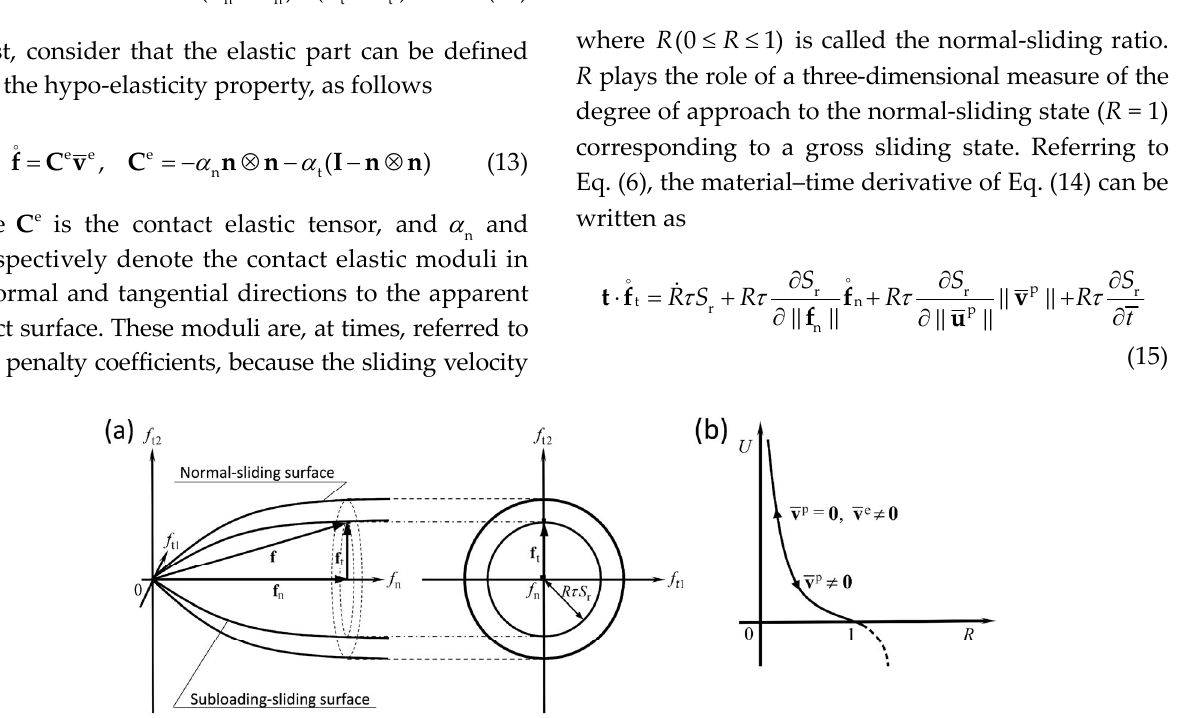
Fig. 1 Concept of subloading-friction model: (a) normal-sliding and subloading-sliding surfaces; and (b) evolution rule of normal-sliding